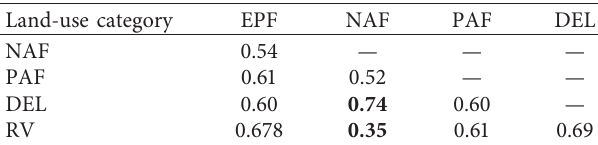
Table 3: Jaccard’s coefficient of similarity in species composition of the five land-use